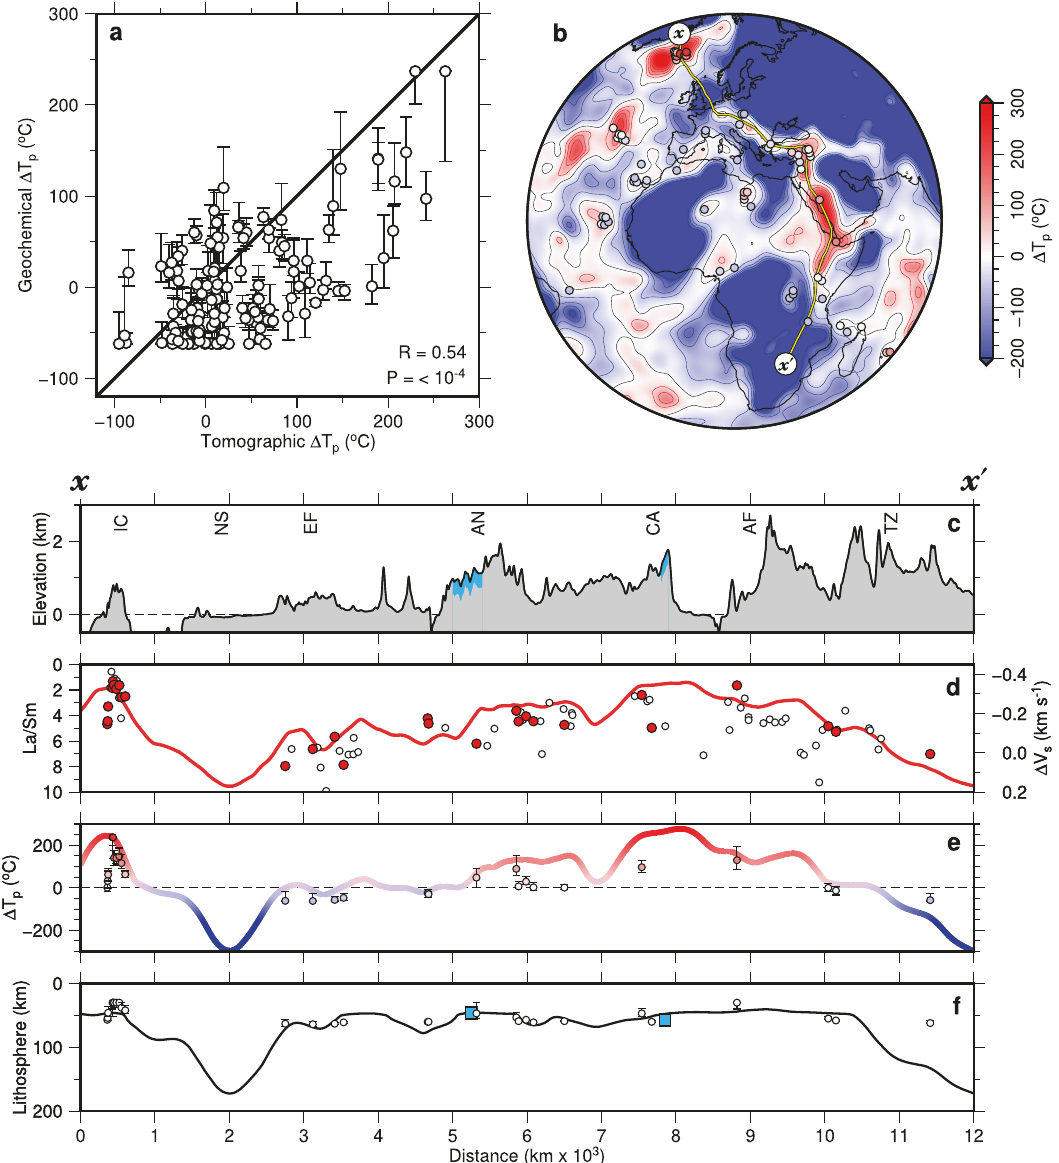
Fig. 5 Relationships between calculated temperatures,lithospheric thickness variation, and dynamic topography. a Diagram showing relationship between Δ T p determined by geochemical inverse modeling and that determined by calibration of SL2013sv tomographic model where ambient mantle temperatures are assumed to be 1312 °C and 1333 °C, respectively. Open circles with vertical and horizontal error bars = calculated values of temperature for global distribution of intraplate volcanism ± 1.5× minimum mis fi t; black line 1:1 relationship; R = correlation coef fi cient; P = population correlation coef fi cient; R = 0.28 is minimum value of R distinguishable from zero at signi fi cance level of = 0.001. b Map showing spatial variation of average value of Δ T SL2013sv tomographic model. Red/white/blue contours = positive/zero/negative values of Δ T p at depths of 150 ± 25 km calculated from p at intervals of 50 °C; colored circles = geochemical values of Δ T p ; yellow line between x and x 0 = locus of transects shown in panels c – f . c Transect from x to x 0 that intersects Iceland (IC), North Sea (NS), Eifel (EF), Anatolia (AN), Central Arabia (CA), Afar (AF) and Tanzania (TZ). Black line with gray polygon = topographic pro fi le; dashed line = reference sea level; blue polygons = loci of uplifted Cenozoic marine strata 58,59 . d Red line = average values of Δ V s at depths of 150 ± 25 km along transect calculated from SL2013sv tomographic model; open circles = observed values of La/Sm averaged into 1° bins that lie within <200 km of transect; red circles = bins with > 5 values of La/Sm. e Colored ribbon = average values of Δ T p at depths of 150 ± 25 km calculated from SL2013sv tomographic model where color scale is shown at right-hand side of panel b ; colored circles with vertical bars = values of Δ T p calculated for screened and binned version of Database 1 ± 1.5× minimum mis fi t. Dashed black line at Δ T p = 0 is for visual guidance. f Black line = lithospheric thickness variation along transect calculated from SL2013sv tomographic model; circles with vertical bars = estimates of lithospheric thickness determined by geochemical modeling ± 1.5× minimum mis fi t; blue squares = present-day lithospheric thickness estimated from elevation of marine rocks by assuming combination of lithospheric mantle thinning, where original thickness is 120 – 150 km, and sub-plate thermal anomaly with thickness of 100 km whose magnitude is taken from panel e